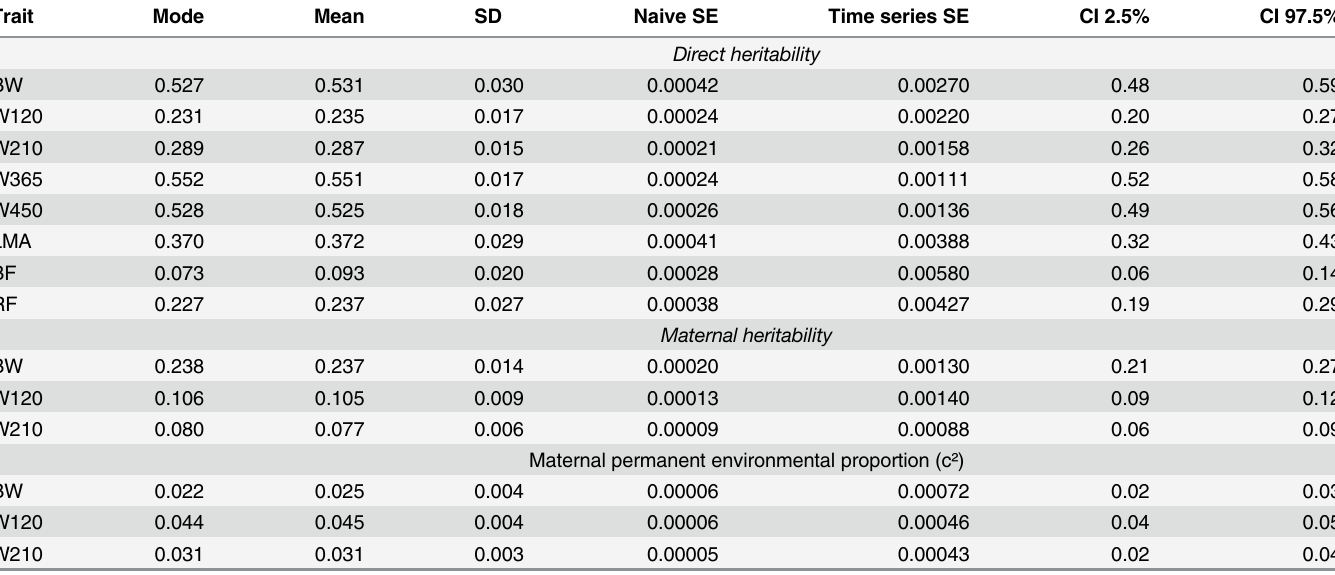
BW, birth weight; W120, weight at 120 days of age; W210, weight at 210 days of age; W365, weight at 365 days of age; W450, weight at 450 days of age; LMA: longissimus muscle area; BF: back-fat thickness; obtained between the 12th and 13th ribs; and RF: rump fat